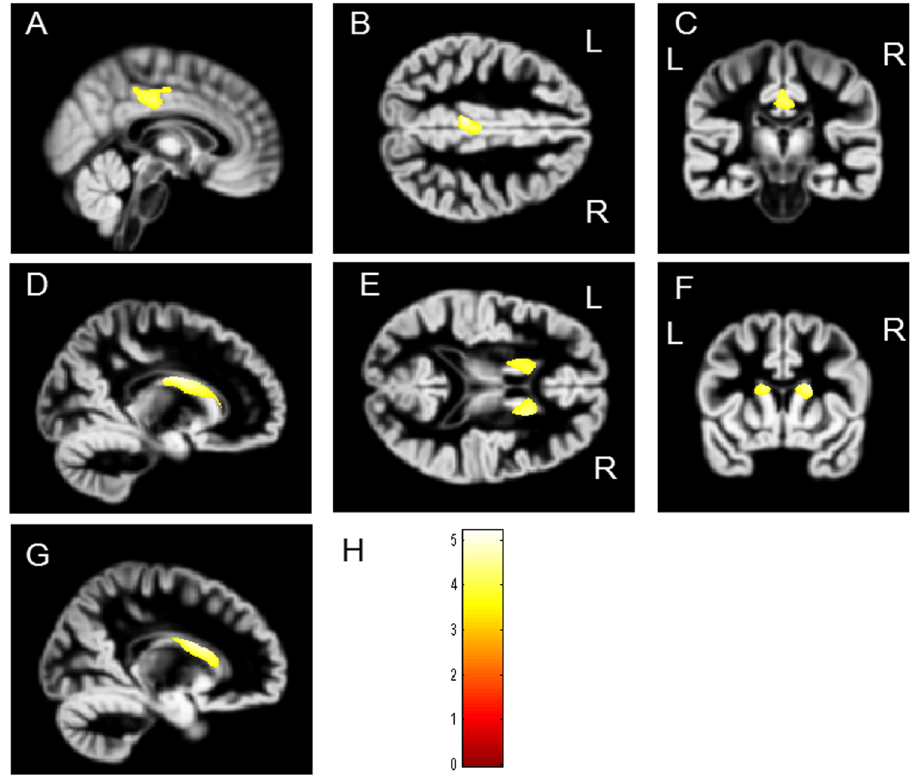
Fig 2. Clusters of significantly decreased gray matter volume in Val/Val individuals compared with that in Val/Met individuals. The SPM {t} is displayed onto the Diffeomorphic Anatomical Registration through Exponentiated Lie Algebra (DARTEL) template of gray matter. The volumes of the bilateral caudate and posterior cingulate cortex (PCC) were significantly smaller in Val/Val individuals than in Val/Met individuals (yellow areas). A-C: The sagittal, axial, and coronal images of the PCC. D: The sagittal image of the right caudate. E-F: The axial and corneal images of the bilateral caudate. G: The sagittal image of the left caudate. H: The color bar indicates the